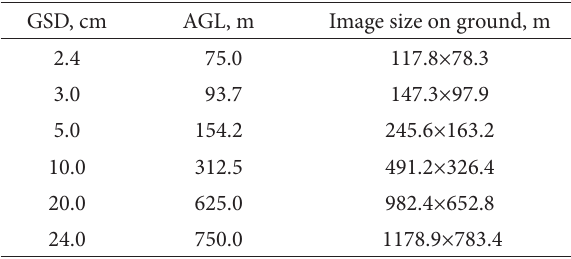
Table 1. Imaging area regarding GSD and AGL ( UX5 Trimble, camera with Voigtlander lens)